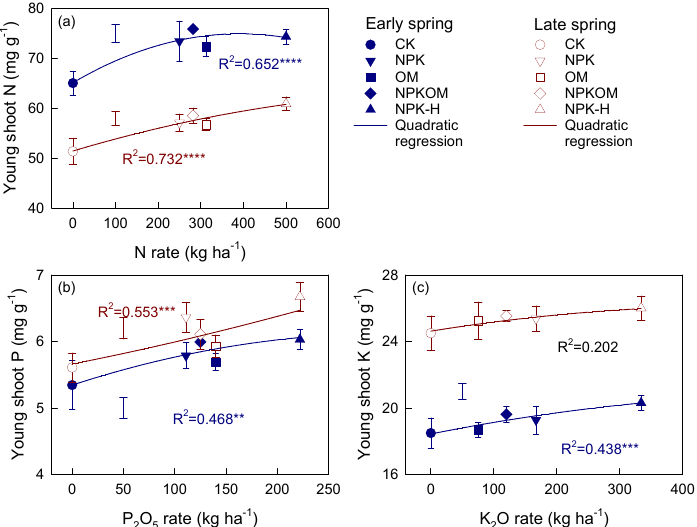
Figure 1. Response of concentrations of N ( a ), P ( b ), and K ( c ) in young shoots to the rate of fertilizers in the early (4 April) and late (21 April 2020) spring. Single bars in color without data point are LSD values indicative of significant difference among treatments. Quadratic regression lines are indicated with R 2 values and significance levels (**, p < 0.01;***, p < 0.001; ****, p < 0.0001; n = 20). Mature leaves of NPK-H had the highest N and P concentrations, followed by NPK and NPKOM (Figure 2a,b). Mature leaves of OM had significantly lower N and P concentrations than NPK and NPKOM. K concentrations of mature leaves in NPK-H, NPK, and NPKOM were not significantly different but were higher than those in OM (Figure 2c). Similarly, the relation between the concentrations of N, P, and K in mature leaves with the rates of nutrients were well described by quadratic regressions (Figure 2). The yield was closely related to N concentration in mature leaves and their relation was well described by quadratic regression (Figure 3a).